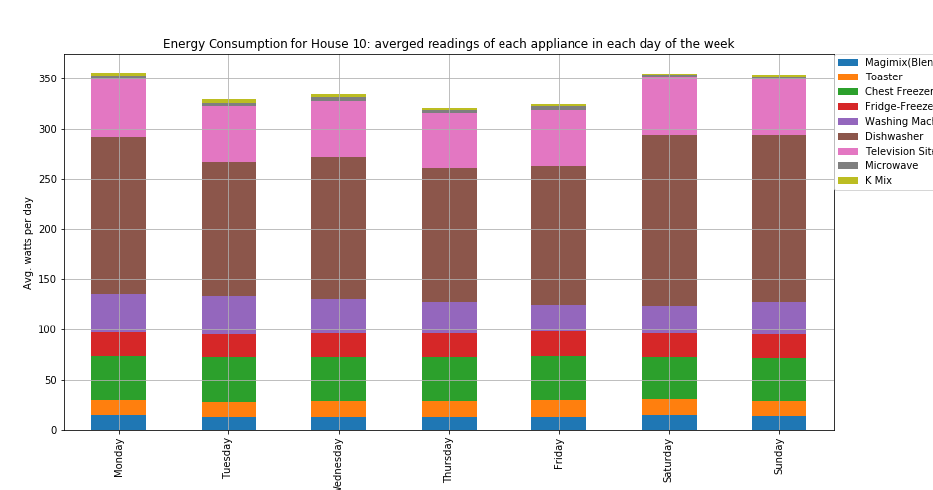
Figure A3. The average consumption per day of home appliances for house 10 with four